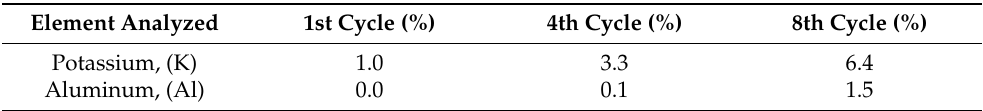
Table 4. Chemical analysis by ICP-AES of biodiesel liquid sample by using beads K 2 CO 3 /Al 2 O 3 catalyst in the transesterification process.